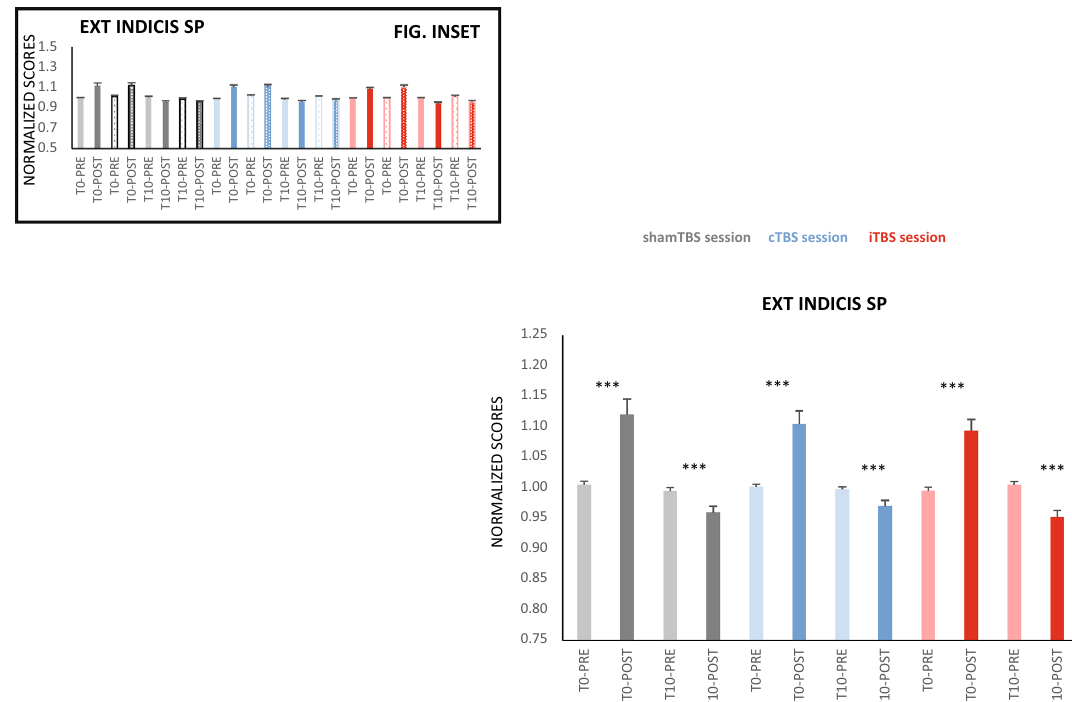
Figure 5. Effects of M1-TBS on extensor indicis SP duration. Ischaemia levels were pooled for extensor indicis (EXT-IND) SP, since they were not significantly different and had no significant interactions with other factors. Responses to cTBS and iTBS did not differ significantly from those observed after shamTBS. EXT-IND SP was significantly larger POST (vs. PRE) FT only for T0 but smaller for T10, and this did not differ across different TBS sessions. Figure insets indicate responses of EXT-IND SP before and after FT in delay and ischaemia conditions for the three TBS protocols (solid bars = no ischaemia, textured bars = ischaemia). The asterisks denoting significance were omitted because they were not significantly different from the pooled response in the main plot. **p ≤ 0.01, ***p ≤ 0.001. The y-axis unit scores are equivalent to PRE SP durations for the different sessions (207.7 ms SE 9.3 for shamTBS; 205.9 ms SE 7.3 for cTBS; and 212.7 ms SE 8.3 for iTBS), which did not differ